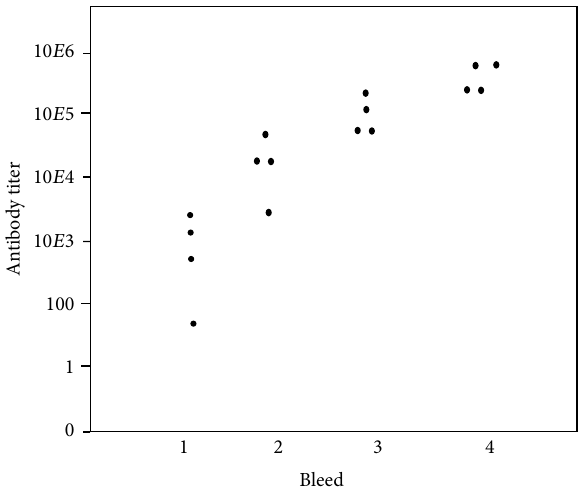
Figure 10: Anti-ApoA1 IgG ELISA titers after subcutaneous YCP- U76L-ApoA1 vaccination. YCPs containing about 90 𝜇 g ApoA1 were administered to four mice on days 0, 14, 28, and 42. Bleeds were on days 13, 27, 41, and